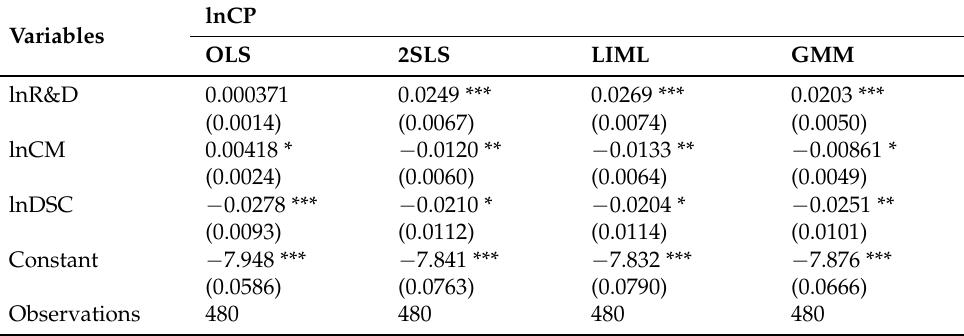
Table 5. Regression results for different instrumental variable